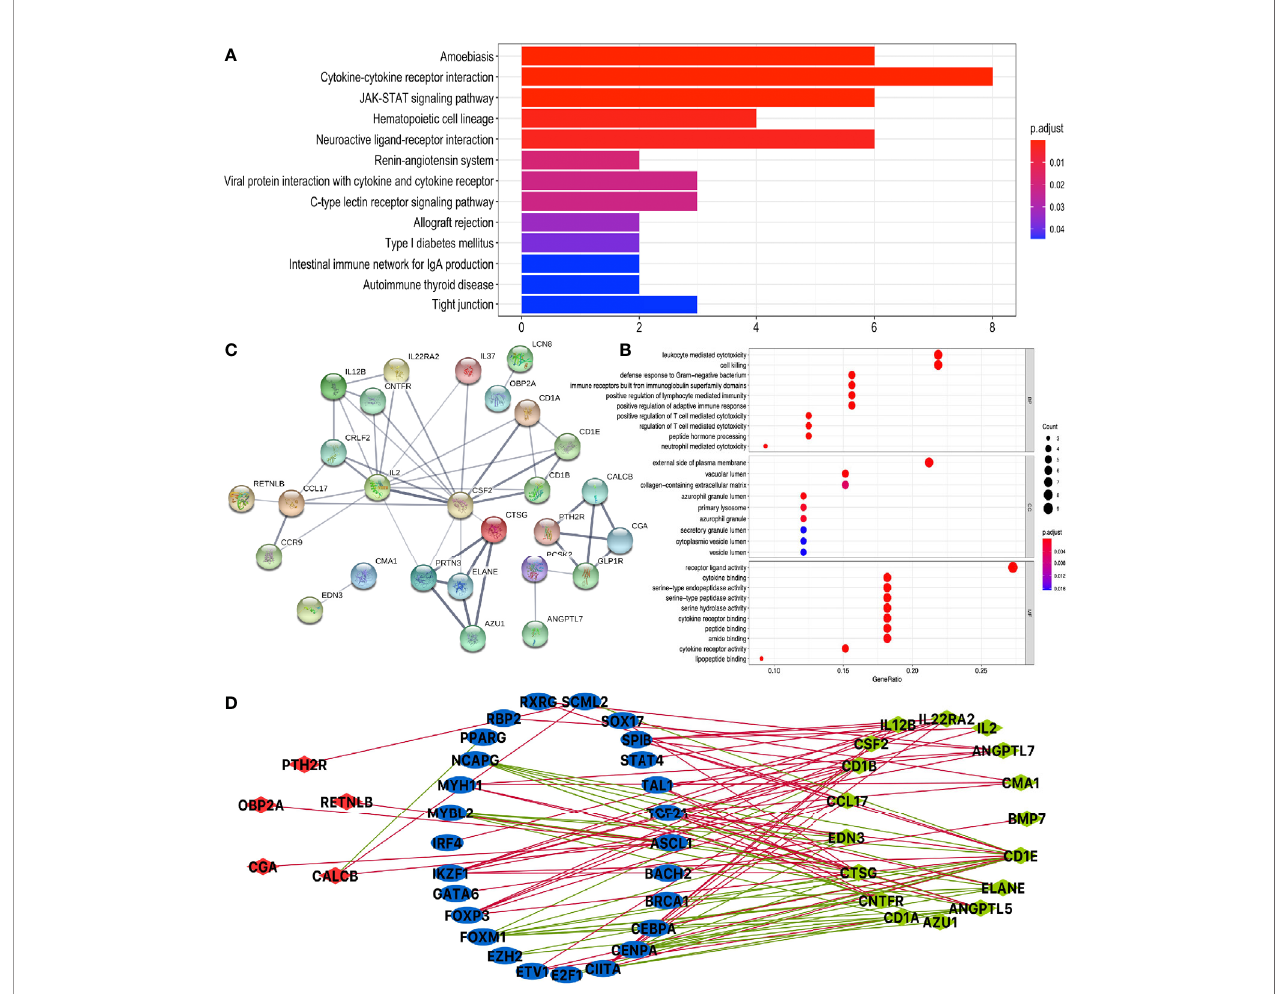
FIGURE 5 | Function enrichment analysis of DEIRGs and TF-DEIRG network in LUAD. (A) KEGG pathway analysis of DEIRGs. (B) GO analysis of DEIRGs. The bar plots and bubble plots show the top terms of biological processes (BPs), cellular components (CCs), and molecular functions (MFs). (C) PPI network of DEIRGs. (D) TF-DEIRG network in LUAD. The blue circle refers to the TFs, the red circle refers to the upregulated DEIRGs, and the green circle refers to the downregulated DEIRGs. The red line is the positive correlation between TFs and DEIRGs. The green line is the negative correlation between TFs and